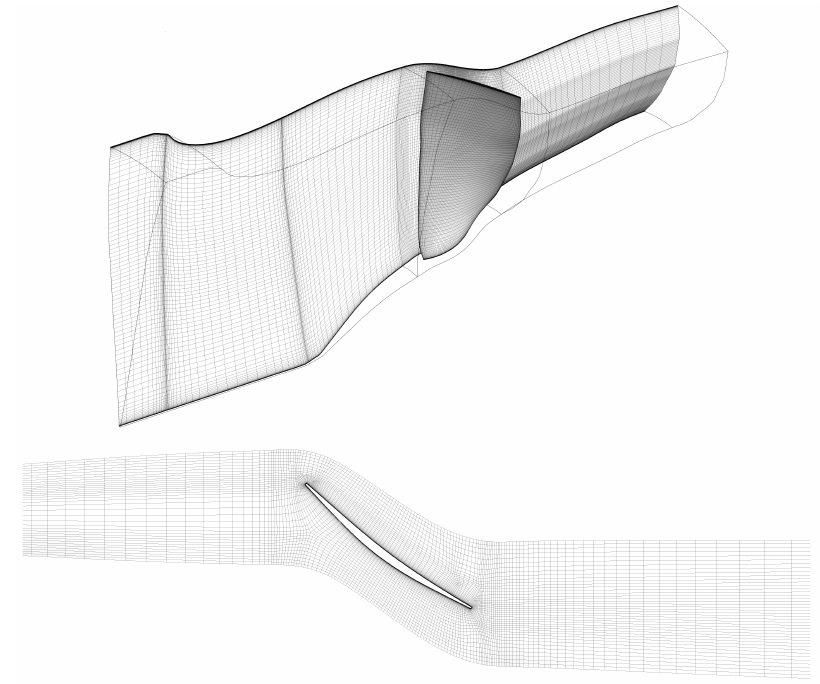
Figure 3. Ducted rotor mesh